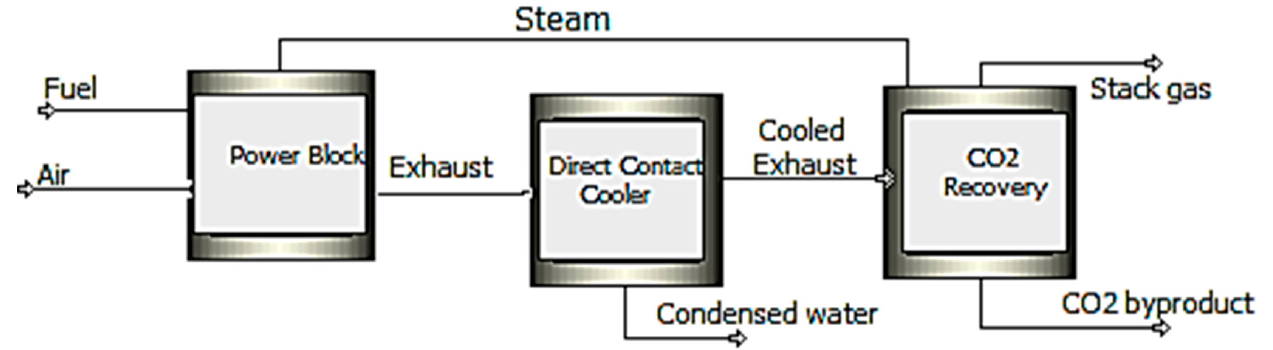
Figure 12. Block diagram of CO 2 recovery in a combined cycle.